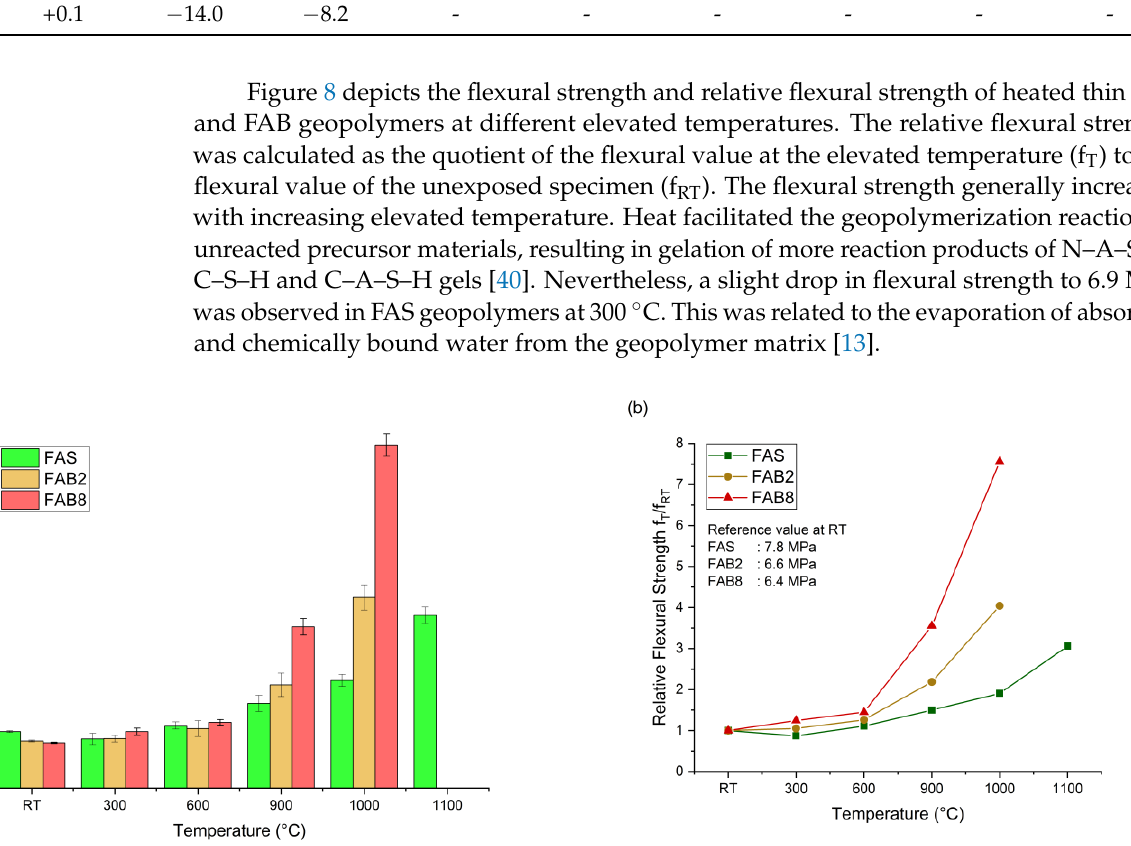
Figure 8. ( a ) Flexural strength and ( b ) relative flexural strength of FAS and FAB geopolymers at different elevated temperatures.